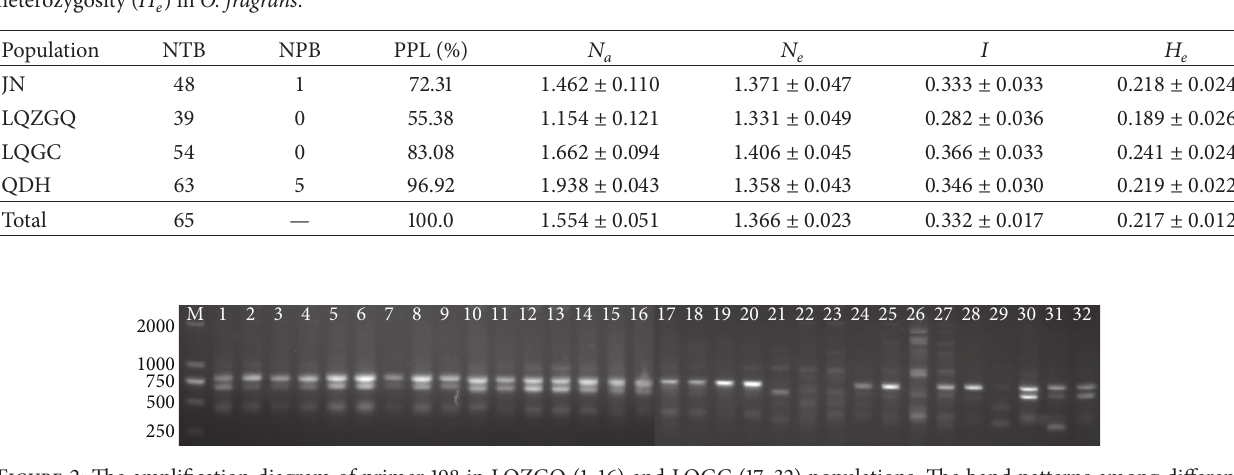
Figure 2: The amplification diagram of primer 198 in LQZGQ (1–16) and LQGC (17–32) populations. The band patterns among different individuals (1–16) in LQZGQ population were similar but those among different individuals (17–32) in LQGC population were